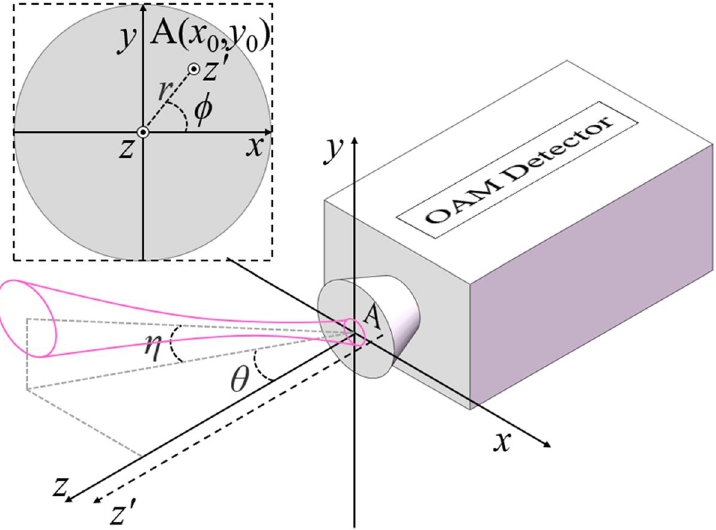
Figure 1. Schematic of the simplest case that the light beam carrying OAM is incident on the detector with